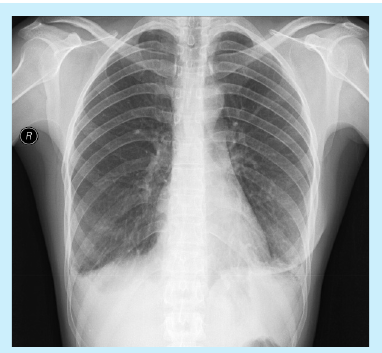
Fig. 4. Significant resolution of bibasal infil- trates post